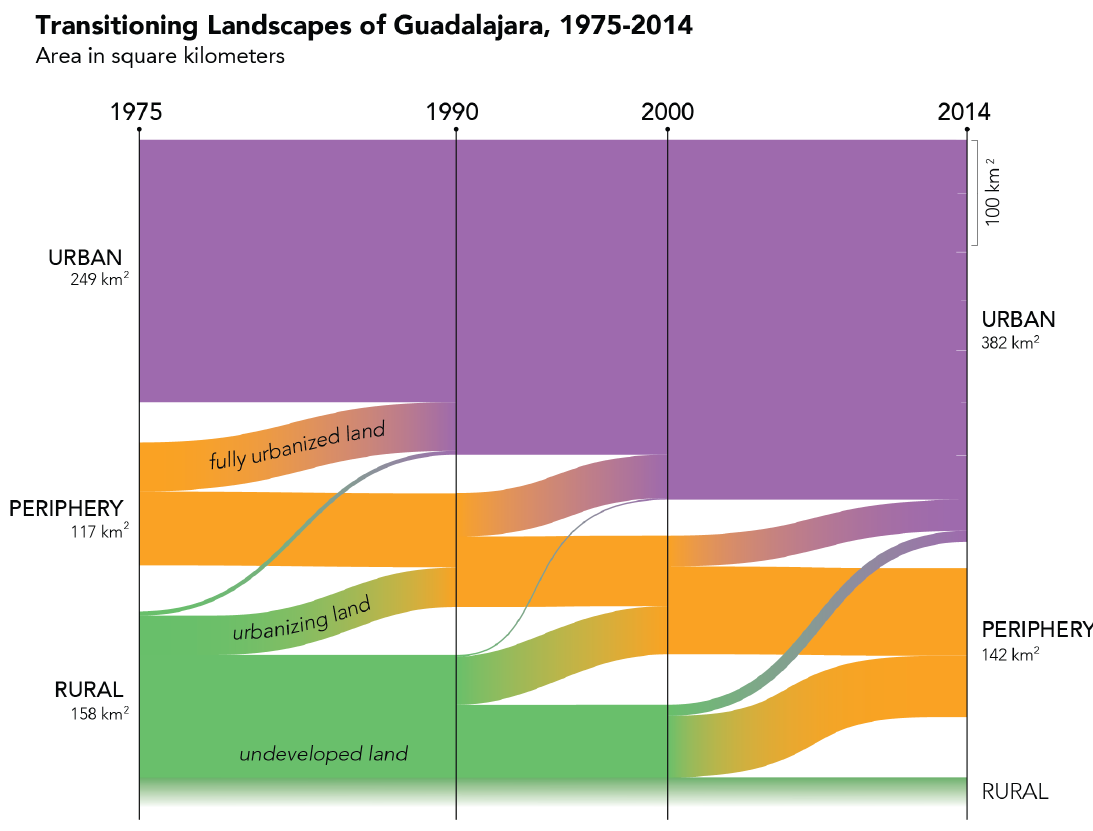
Figure 6. Change in land